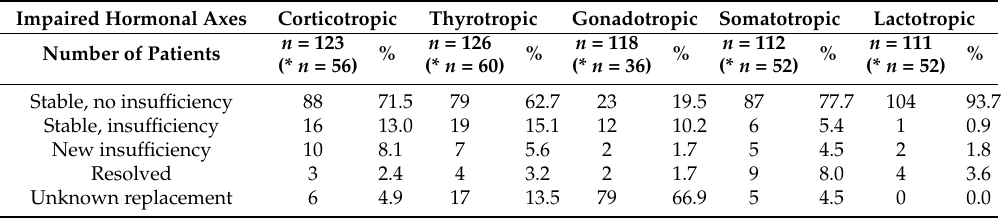
Table 1. Intraindividual changes in pituitary insufficiencies defined by basal laboratory values or by the change of hormone replacement therapy between the first visit and the follow-up.